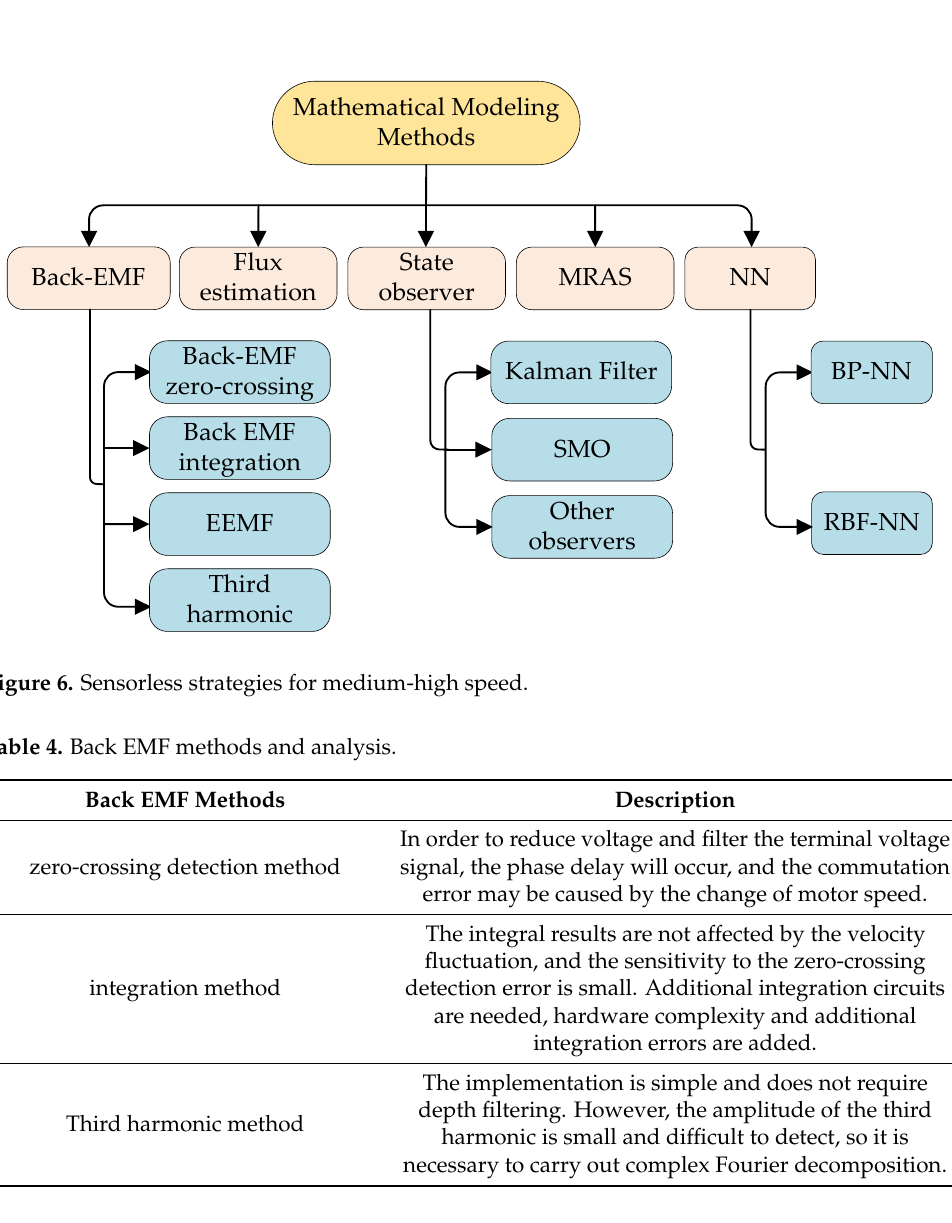
(b) Figure 5. Waveforms of sensorless estimation at zero-low speed. (Initial rotor angle: ( a ) 1 rad; ( b ) 4 rad). 3. Sensorless Control Scheme for Medium-High Speed Operation In addition to the aforementioned method based on salient pole tracking, the sen- sorless control technology of PMSM includes the method of fundamental wave model [9], which relies on the back electromotive force related to the rotational speed of the motor in the fundamental wave excitation model for the estimate of rotor position and speed. As the motor runs at zero speed and very low speeds, while the signal-to-noise ratio of useful signals is extremely low, it is usually difficult to conduct extraction.